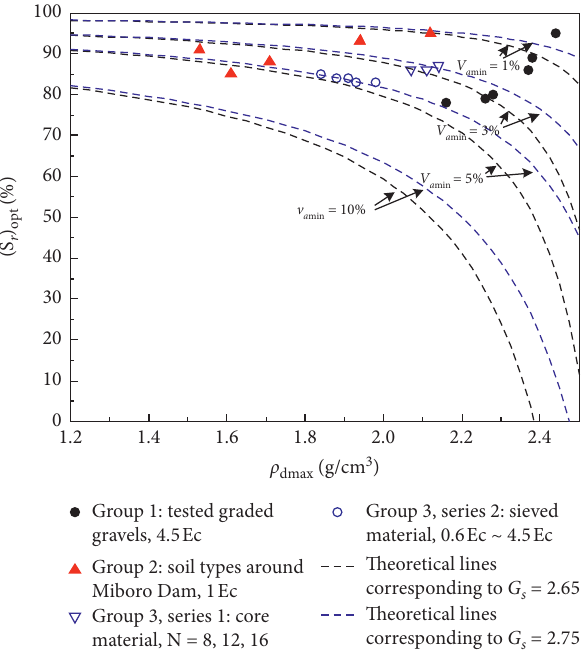
Figure 12: Optimum saturation degree ( S maximum dry density ( ρ d ) max for three groups of coarse soils.